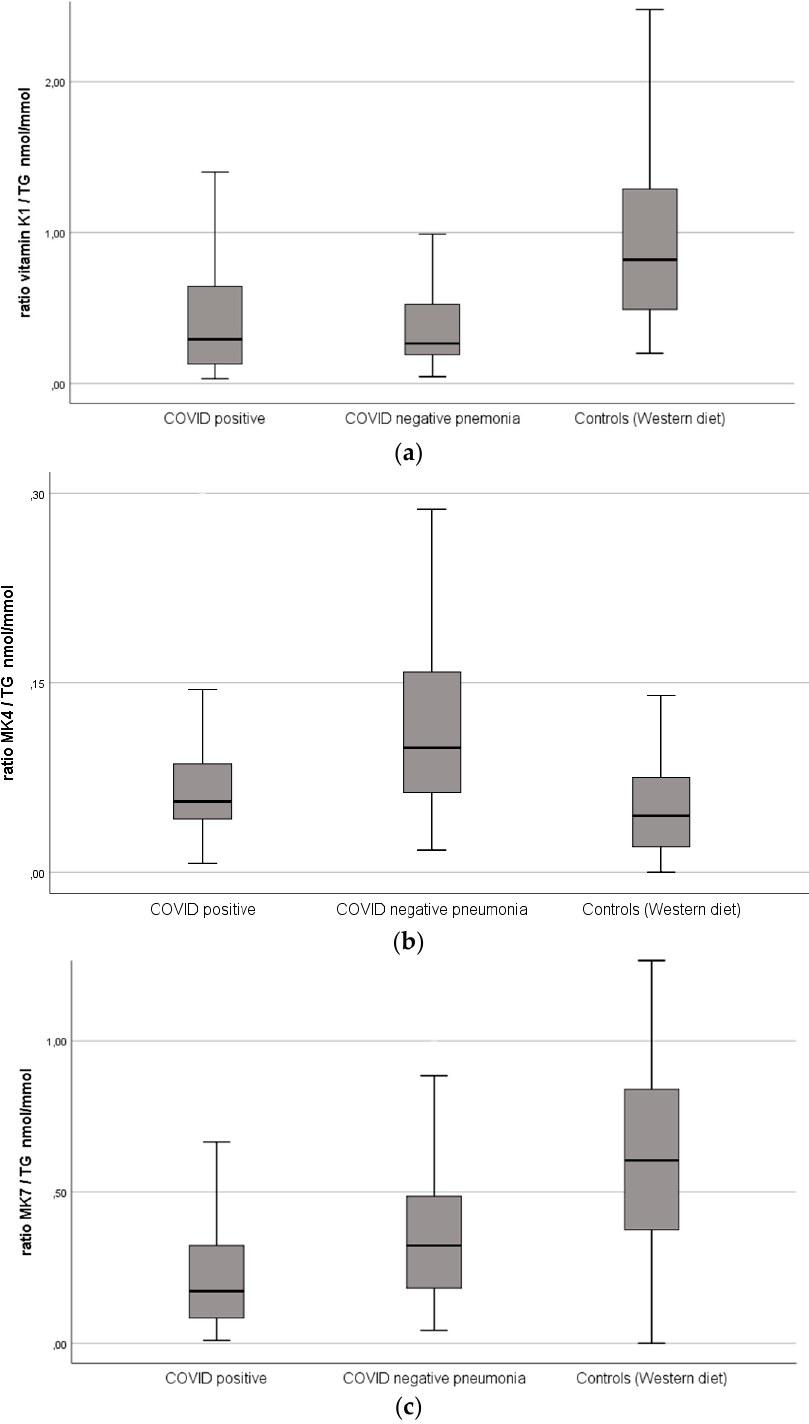
Figure 1. ( a ) Vitamin K1 serum levels normalized by triglyceride levels within the groups. COVID ‐ 19 positive, n = 135, COVID ‐ 19 negative pneumonia, n = 77, controls (Western diet), n = 104. ( b ) Vitamin MK4 serum levels normalized by triglyceride levels within the groups. ( c ) Vitamin MK7 serum levels normalized by triglyceride levels within the groups.